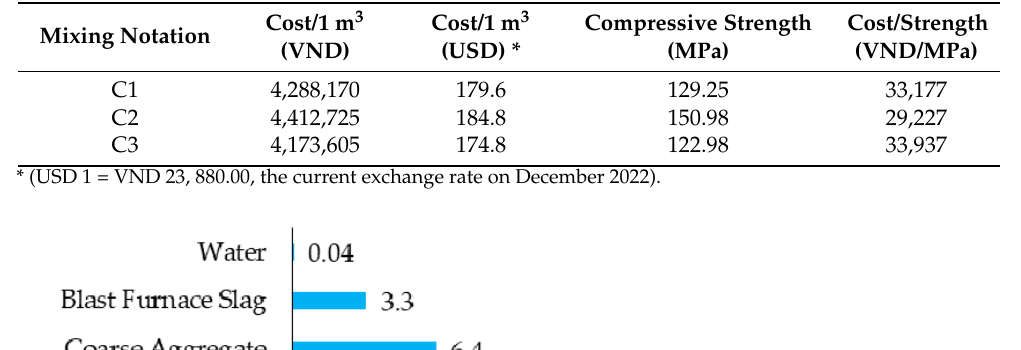
Table 9. Comparison of the cost–strength relationship of UHPC.